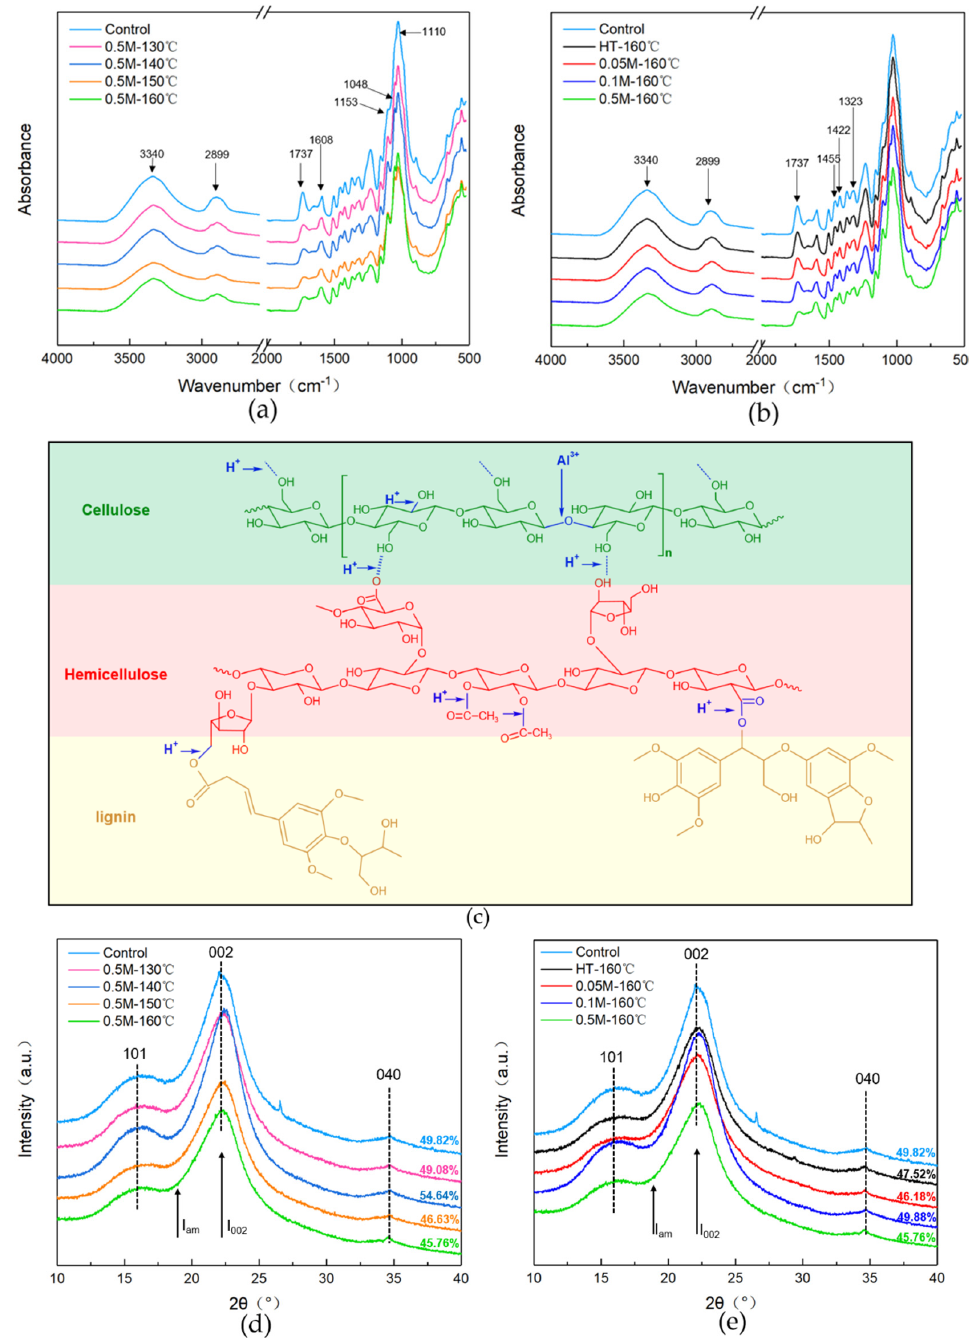
Figure 5. ( a ) ATR-FTIR spectra and ( d ) XRD analysis of the 0.5 M-HT groups. ( c ) Hypothetical diagram of changes in related functional groups. ( b ) ATR-FTIR spectra and ( e ) XRD analysis of samples during heat treatment at 160 °C with different impregnating concentrations.